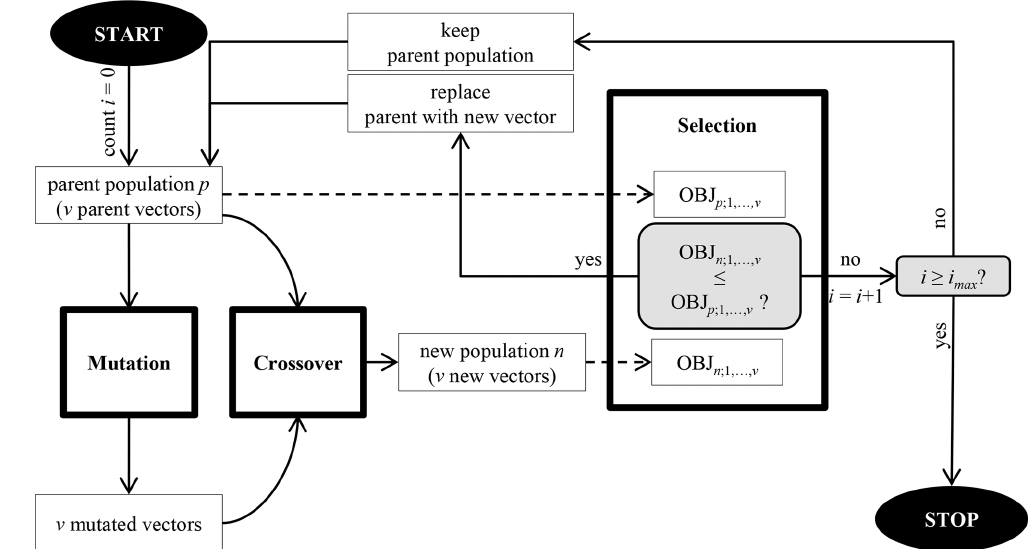
Figure 2. Flowchart of the differential evolution algorithm. “OBJ” refers to the objective function, “ p ” refers to the parent population, “ n ” refers to the new population, “ i ” refers to the iteration, “ i max ” refers to the maximum number of iterations, and “ v ” refers to the number of vectors. Reprinted from Gebauer et al. (2019).